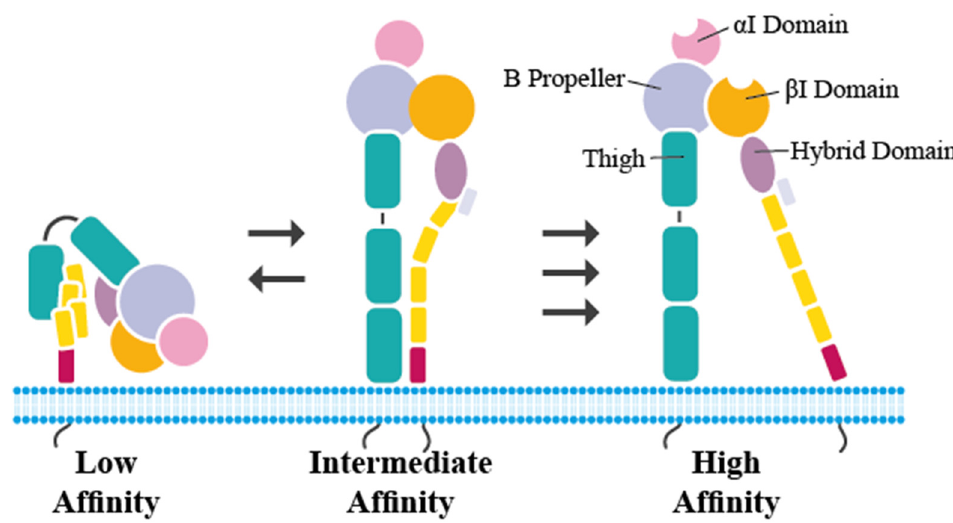
Figure 3. Conformational states of LFA-1 (adapted from Walling et al. [33]). LFA-1 exists in three different conformational states: The low-affinity state (bent-closed) with the headpiece close to the plasma membrane, the intermediate affinity state (extended-closed) with straightened legs, and a closed headpiece and the high-affinity state (extended-open) with extended legs and an open head- piece.